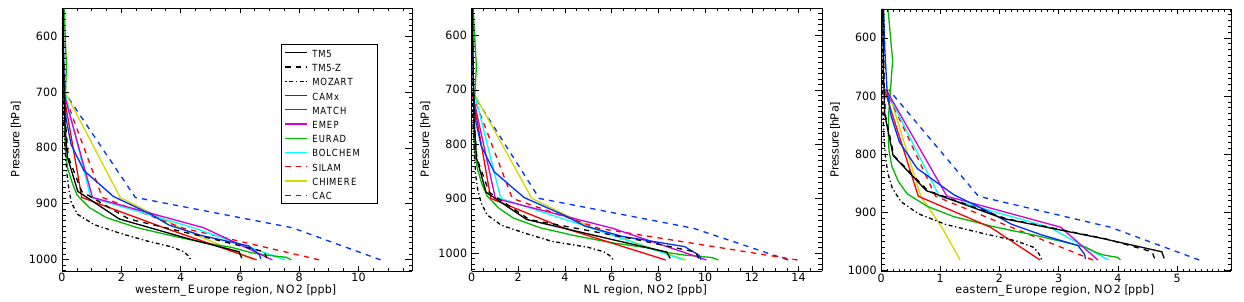
Fig. 9. Monthly mean, area-averaged profiles for